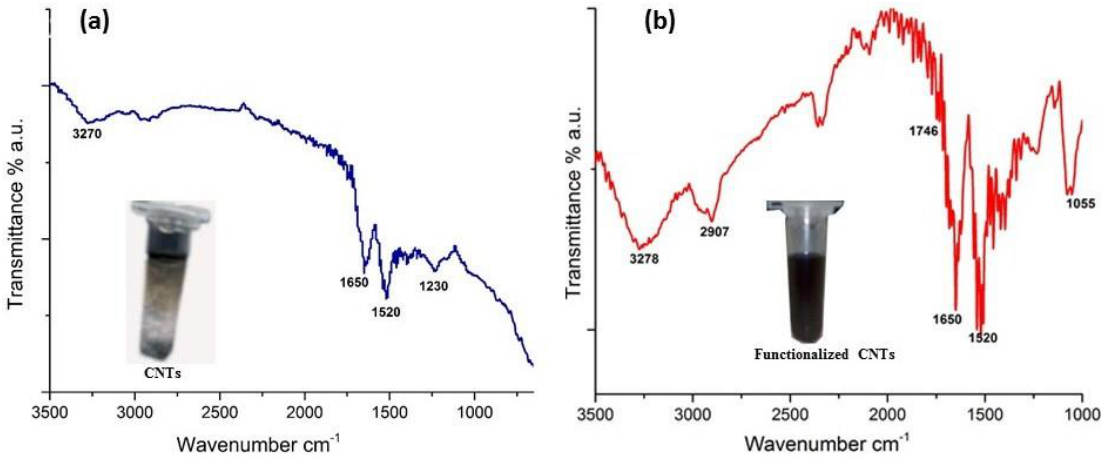
Figure 1. Fourier transform infrared (FTIR) spectra of pure multi-walled carbon nanotubes (MWCNTs) ( a ) and functionalized MWCNTs ( b ), insets shows the dispersion of both in water.